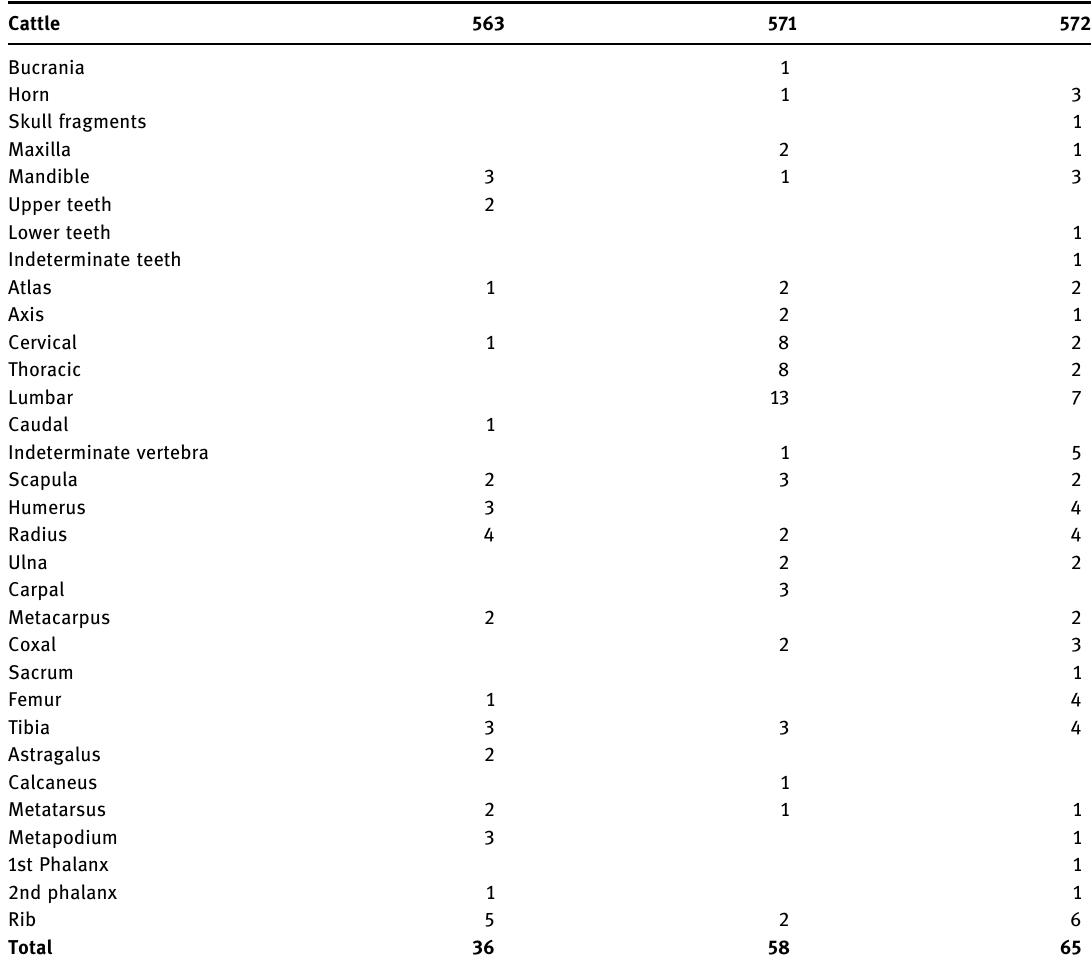
Table 3: Cattle anatomical parts discovered in three ditch segments from the LBK enclosure of Menneville “ Derrière le Village ” : 563, 571, 572 ( excavations 2013 – 2016